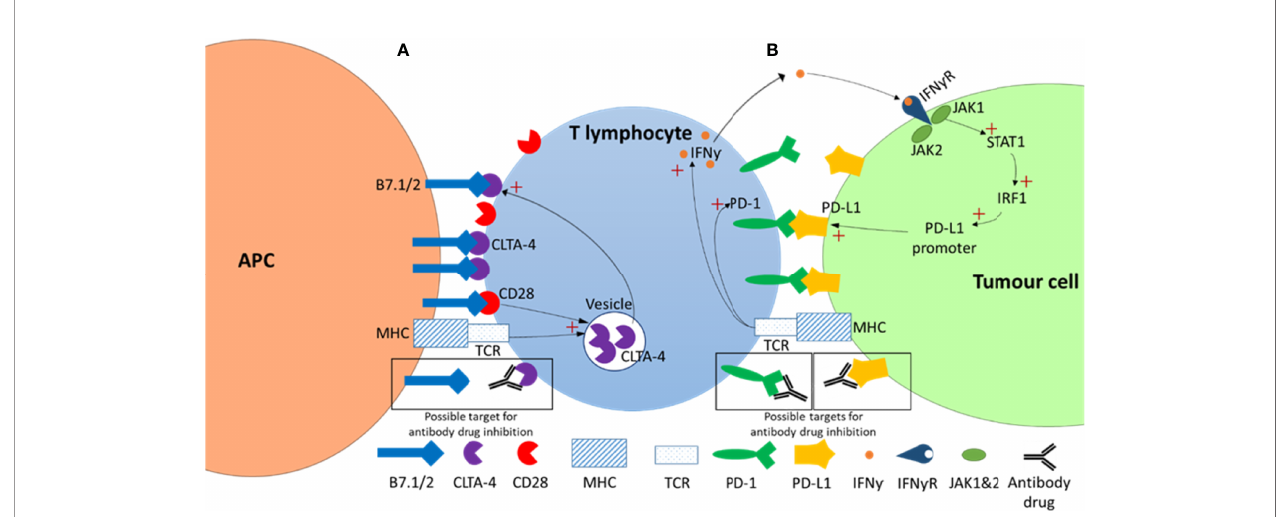
FIGURE 2 | CTLA-4 and PD-1 checkpoint inhibitor pathways. (A) CTLA-4 pathway. In this pathway strong TCR-HMC and CD28-B7 binding signals initiate the exocytosis of the CTLA-4 from the intracellular vesicles to the T cell surface. As CLTA-4 has a higher binding af fi nity then CD28 for B7, this results in a net negative signal that results in reduced T cell proliferation, survival and a decrease in growth cytokines such as IL-2. (B) In the PD-1/PD-L1 pathway TCR-HMC signalling up regulates both PD-1 and interferon- g (IFN ƴ ) expression. The increased of IFN ƴ in the tumor microenvironment activates the signalling pathway of Janus kinase (JAK)/ signal transducer and activator of transcription (STAT) which activates the transcription factor interferon regulatory factor 1 (IRF1), which in turn induces PD-L1 expression. PD-1/PD-L1 interaction results in in a net negative signal and ultimately reduced T cell survival, proliferation and cytotoxic production. Possible antibody drug targets in both pathways are indicated showing antibody-target interaction (within black